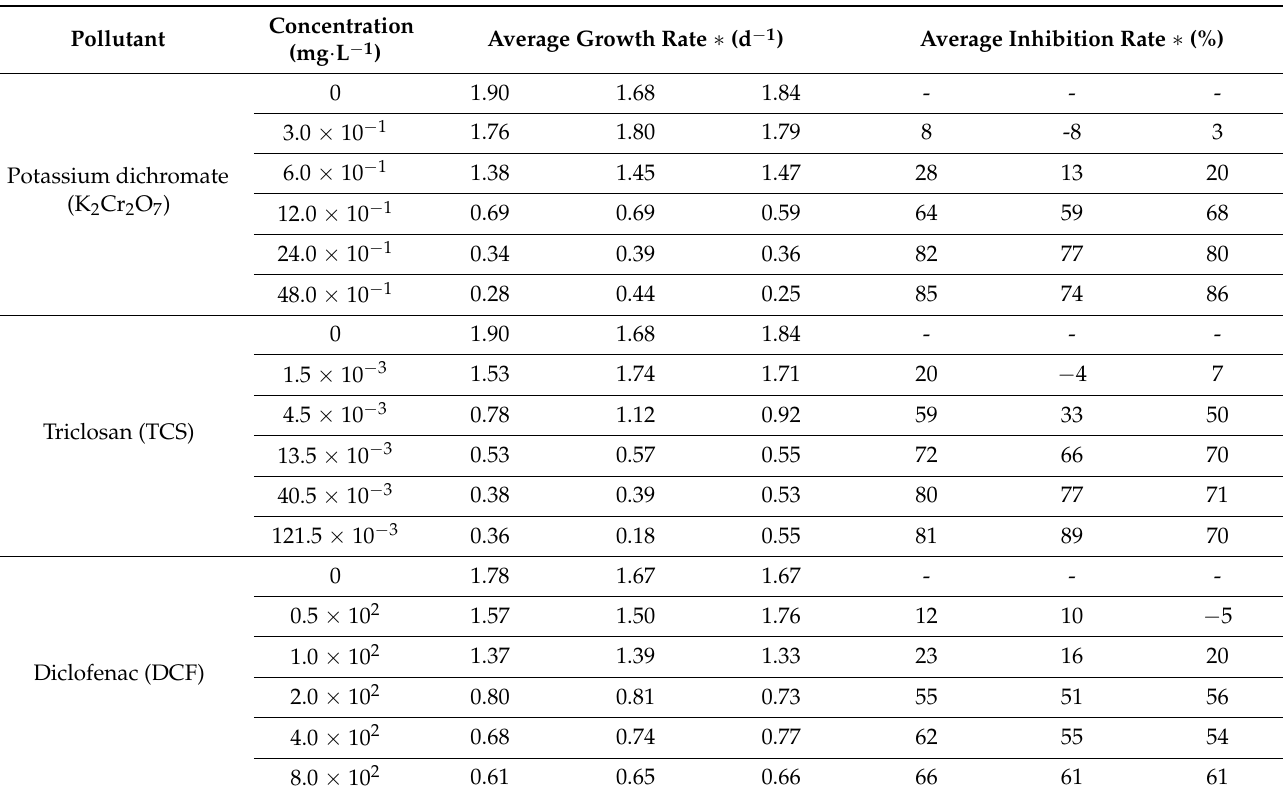
Table 3. Results of tests with R. subcapitata in the alginate (immobilized) form.